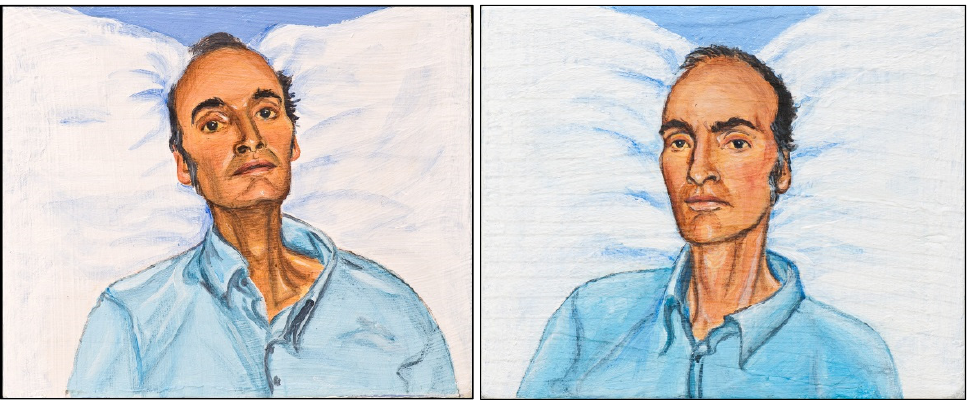
Figure 1. The real man and the guarded man